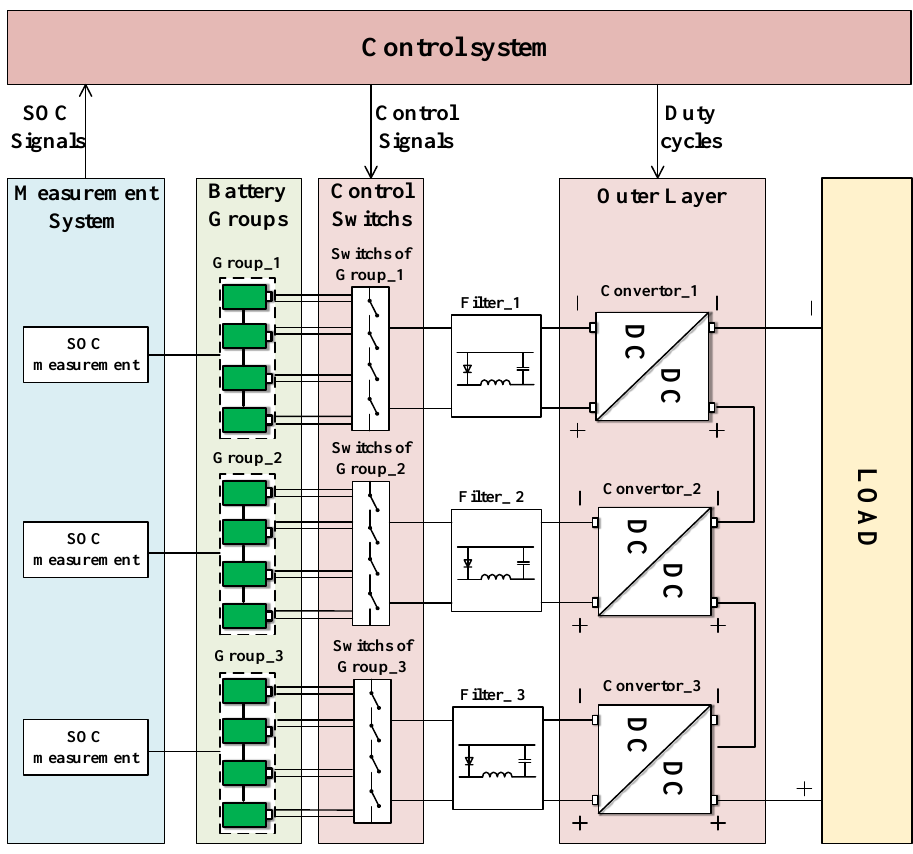
Figure 12. Schematic diagram of proposed method.